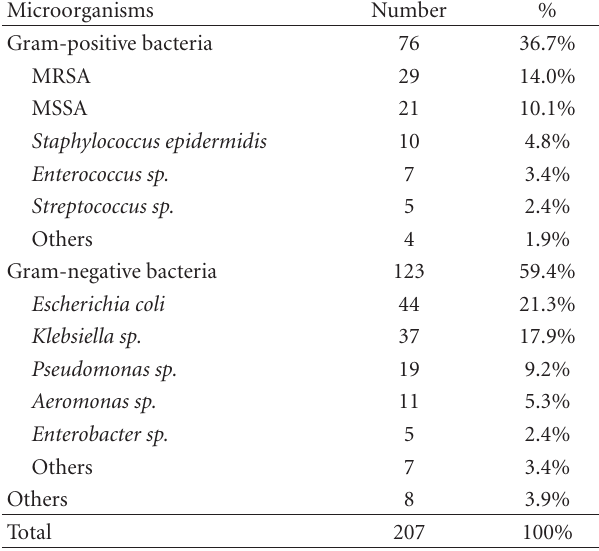
Table 1: Microorganisms isolated from blood cultures in patients with liver